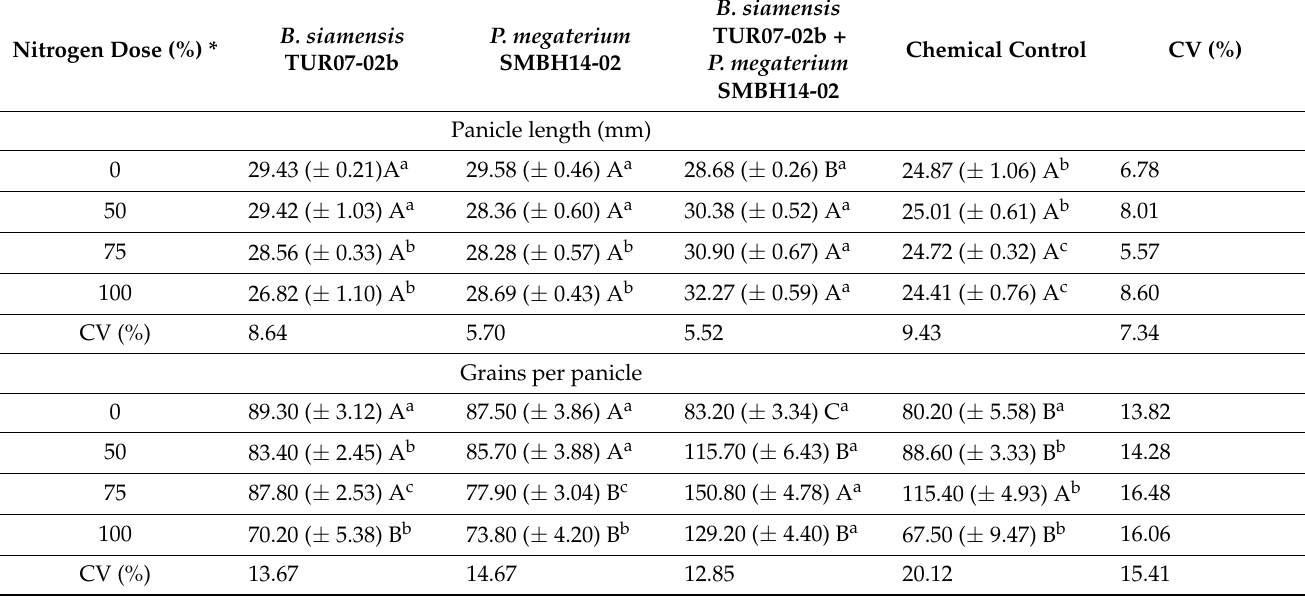
Table 5. Effect of the inoculation of endophytic B. siamensis and P. megaterium on the agronomic parameters of Oryza sativa var. “Bellavista” growing under greenhouse